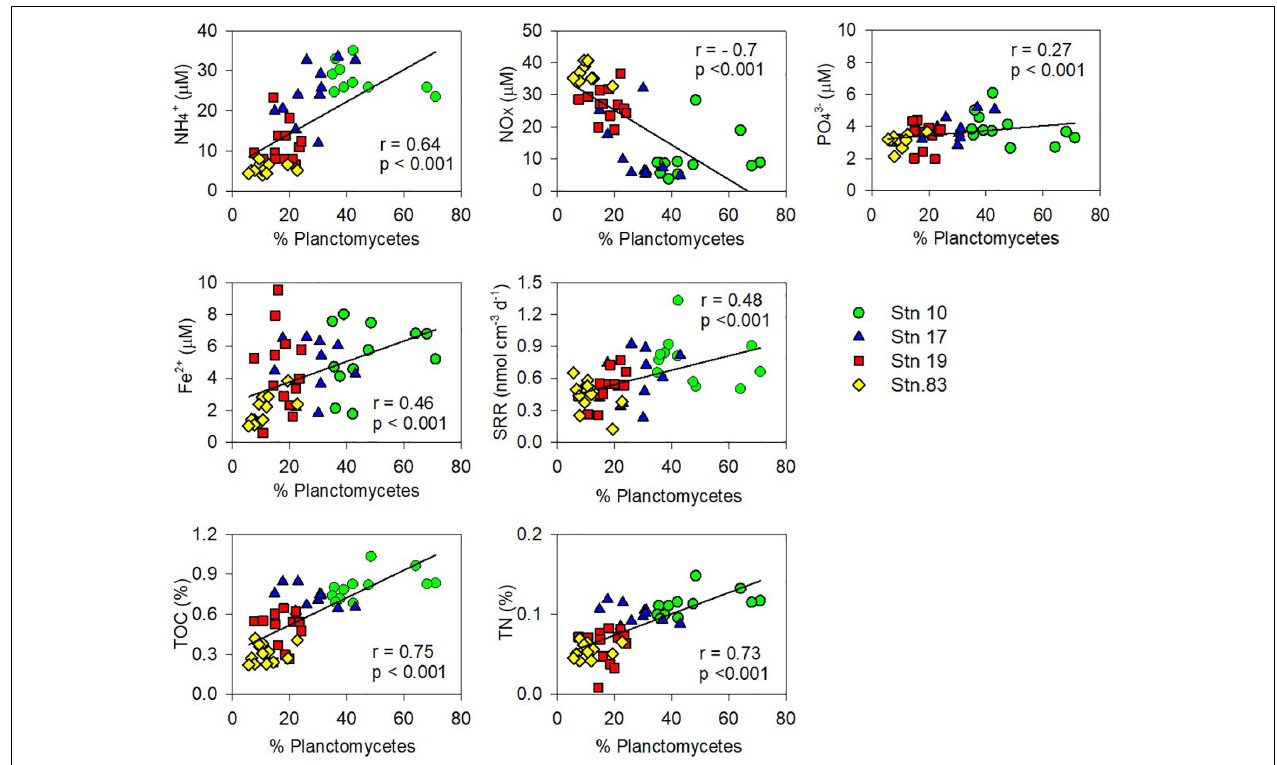
FIGURE 6 | Correlations between the relative abundance of the planctomycetal 16S rRNA genes in total sequences and geochemical properties [the concentrations of NH + 4 , NO X (NO − 3 + NO − 2 ), PO 3 − 4 , and Fe 2 + in pore-water, sulfate reduction rate (SRR), and contents of total organic carbon (TOC) and total nitrogen